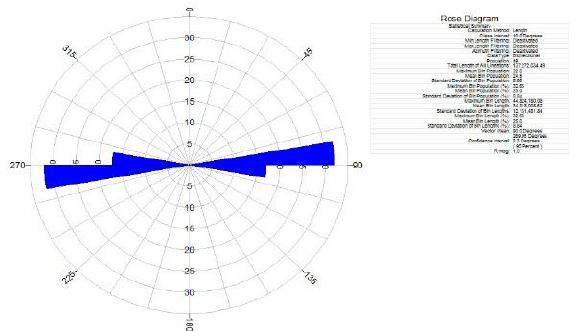
Figure 8. Rose diagram of lineament extraction from geological